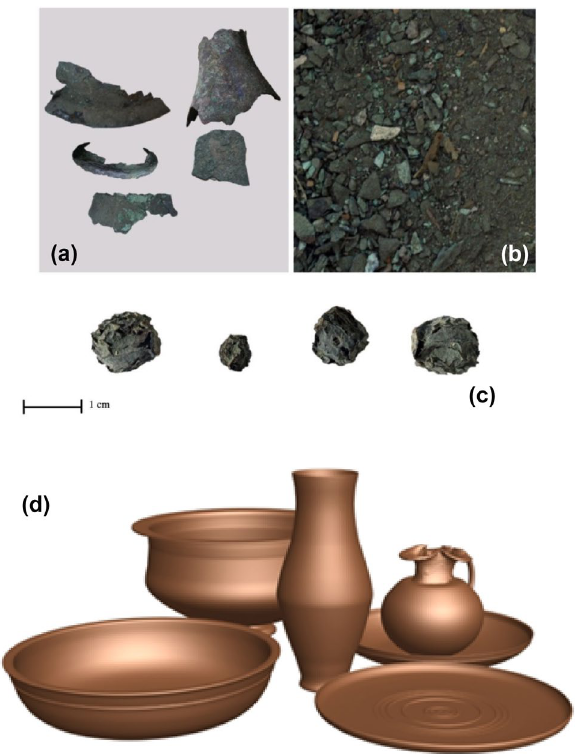
Figure 1. The excavated metal fragments showing variable shapes and sizes ( a ), other tiny fragments in a mixture of corrosion products and soil grains ( b ), the archaeobotanical material ( c ) and utensils rendered by virtual reconstruction of fragments ( d ) 1 (Processed using Adobe Photoshop